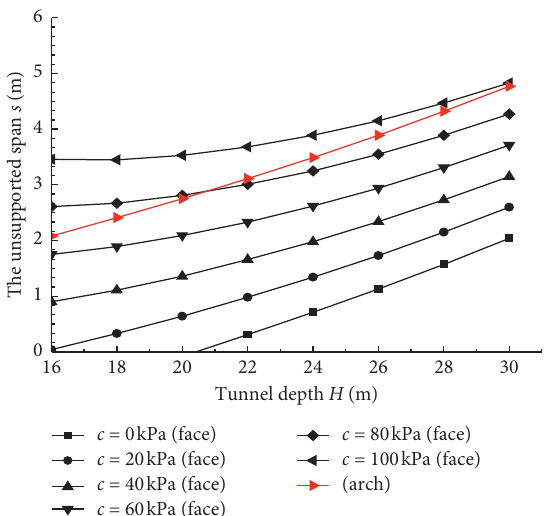
Figure 14: Curves of correlation between the unsupported span and limiting support